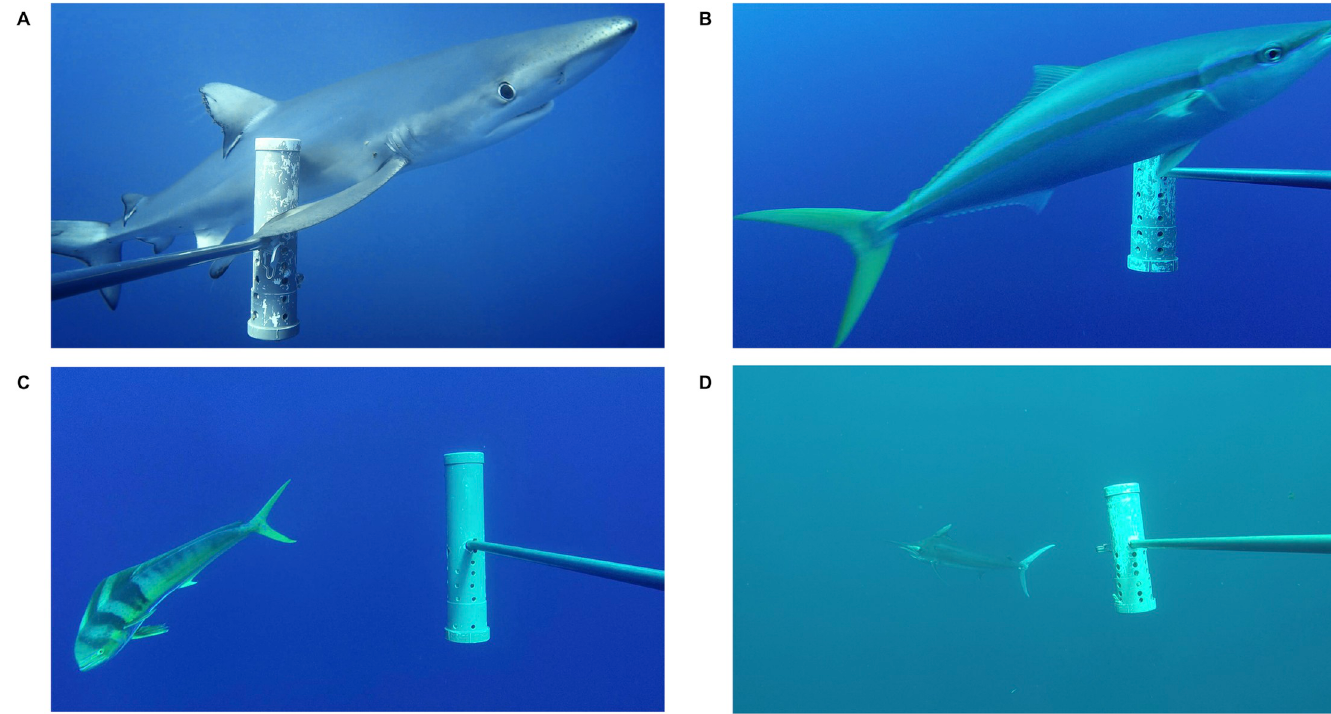
Fig 2. Examples of midwater predators surveyed by the BRUVS. (A) Blue shark ( Prionace glauca ). (B) Rainbow runner ( Elagatis bipinnulata ). (C) Mahi-mahi ( Coryphaena hippurus) . (D) Black marlin ( Istiompax indica) . BRUVS, baited remote underwater video system.